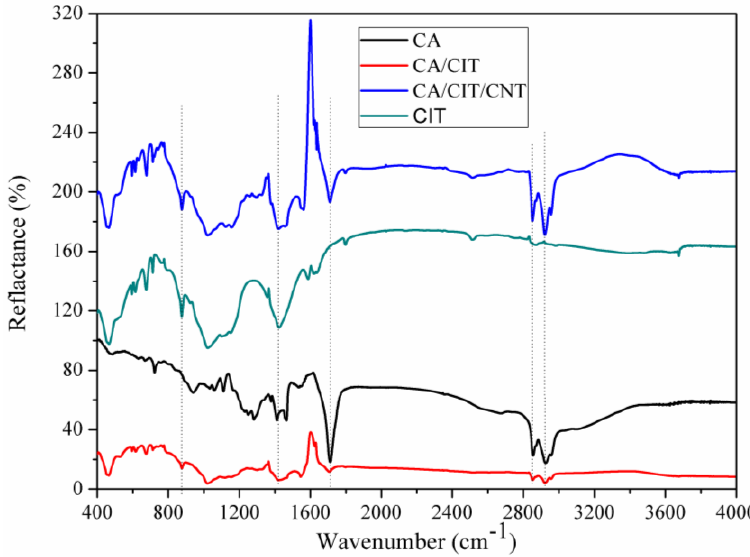
Figure 8. FTIR spectra of CA, CIT, CA/CIT, and CA/CIT/CNT samples.